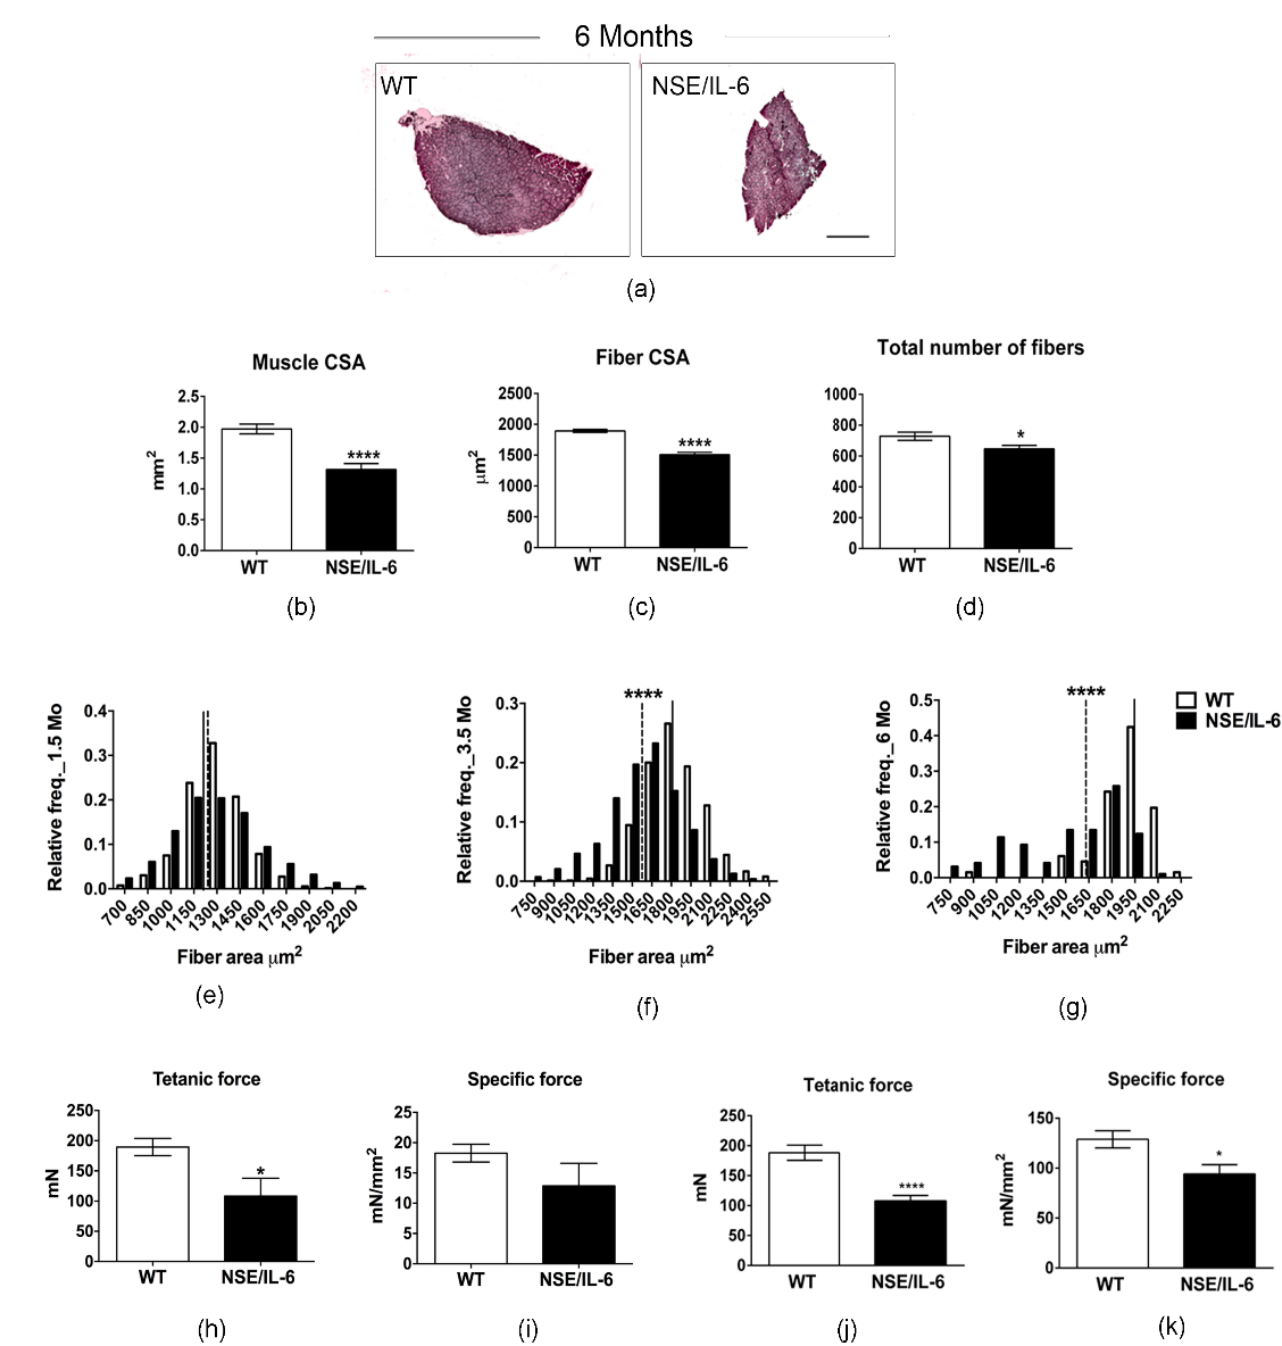
Figure 3. IL-6 overexpression promotes muscle atrophy and wasting and affects the functional performance of skeletal muscle in adulthood. ( a ) Hematoxylin and eosin staining of transverse section of soleus muscles from indicated genotypes at 6 months of age. Scale bar 500 µ m. ( b – d ) Analysis of morphologic and morphometric parameters in transgenic (NSE/IL-6) and wild type (WT) soleus muscle at 6 months of age. Data are represented as average ± SEM. n = 10; * p < 0.05, **** p < 0.0001. Statistical significance assessed by unpaired Student’s t -test. ( e – g ) Frequency distribution of myofiber-cross sectional area in transgenic (NSE/IL-6) and wild type (WT) soleus at 1.5 ( e ), 3.5 ( f ), and 6 ( g ) months of age. Data are represented as medians. n = 10; **** p < 0.0001. Statistical significance assessed by Mann–Whitney Rank Sum Test. ( h – k ) Physiological properties of soleus muscle from 3.5 ( h , i ) and 6 ( j , k )-month-old wild type (WT) and NSE/IL-6 mice. Tetanic force and Specific force. Data are represented as average ± SEM. n = 15; * p < 0.05, **** p < 0.0001. Statistical significance assessed by unpaired Student’s t -test.